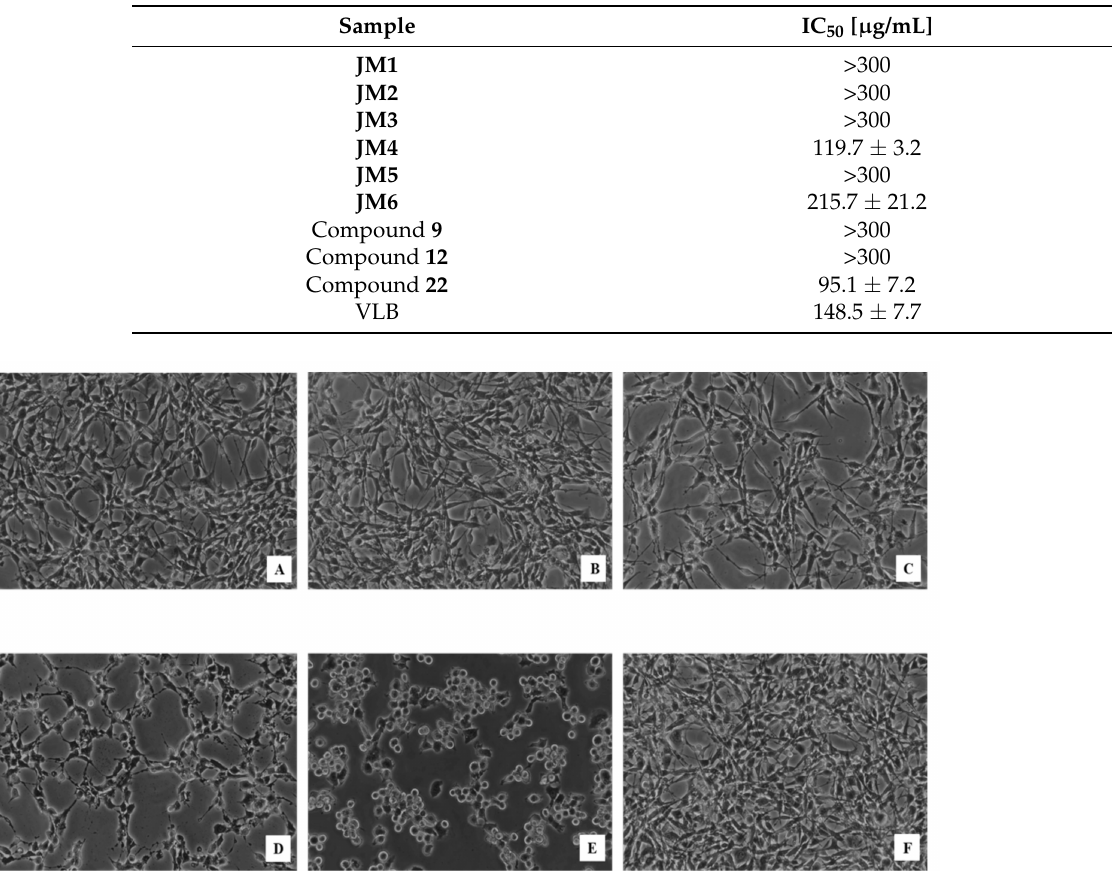
Figure 2. Morphological profile of C32 melanoma cells after 24 h of incubation with JM4 in concentration 25 µ g/mL ( A ), 50 µ g/mL ( B ) and 100 µ g/mL ( C ), 22 at concentration 25 µ g/mL ( D ), and vinblastine sulfate (VLB) at concentration 25 µ g/mL ( E ), compared with untreated control ( F ) evaluated by phase contrast microscopy (magnification ×